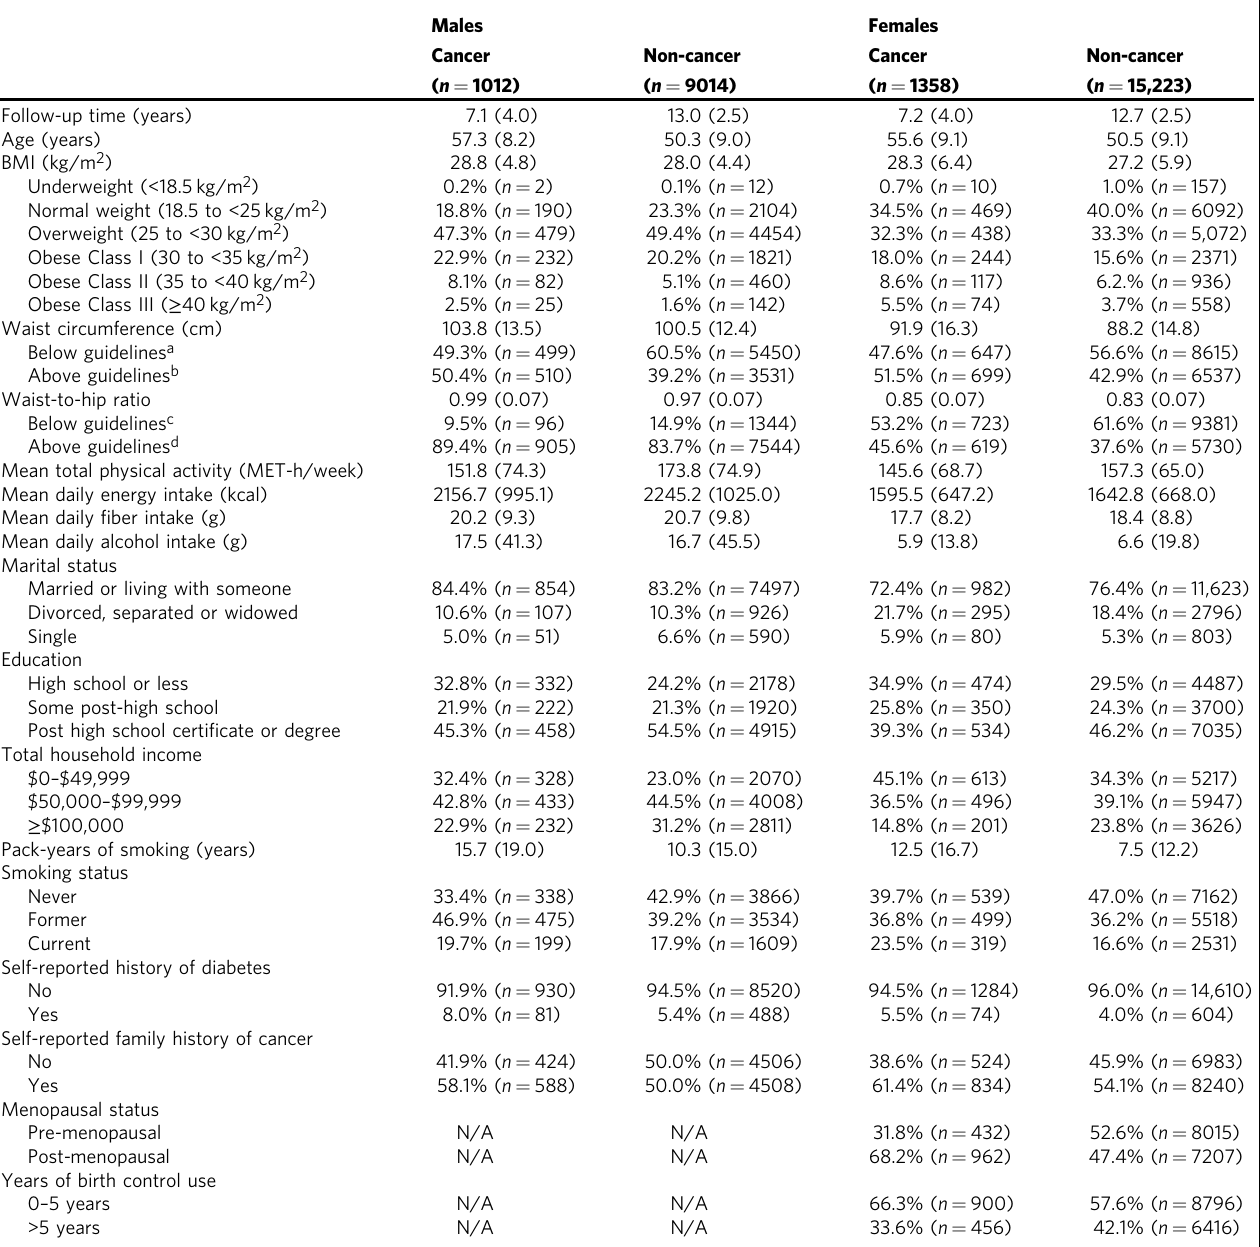
Table 1 Descriptive statistics for consenting ATP participants ( n =